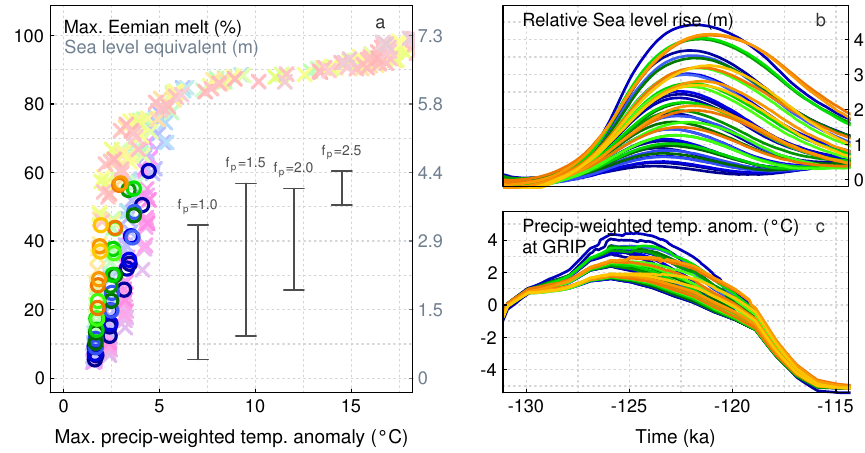
Fig. 9. (a) Maximum percent of Eemian ice loss versus the maximum precipitation-weighted temperature anomaly experienced at GRIP during the Eemian. The percentage of loss is also converted into sea-level equivalent, assuming 100% correspondence to the present- day volume of the GIS. Darker circles and lighter crosses correspond to “valid” and “invalid” simulations, respectively. The valid range corresponding to each choice of the paleo factor, f p , is indicated by the dark lines. The temporal evolution during the Eemian of (b) the Greenland contribution to sea level and (c) the precipitation-weighted annual temperature at GRIP is shown for valid